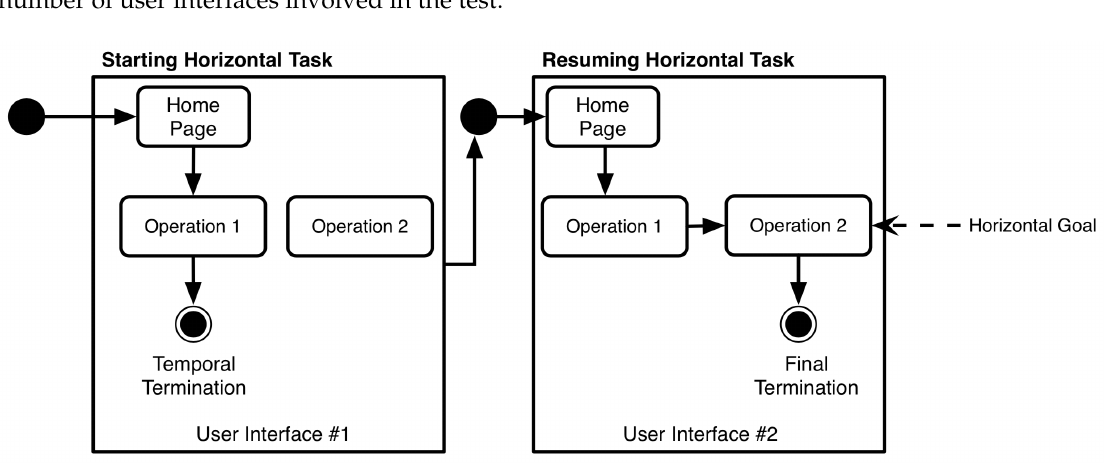
Figure 2. A conceptual view of a horizontal